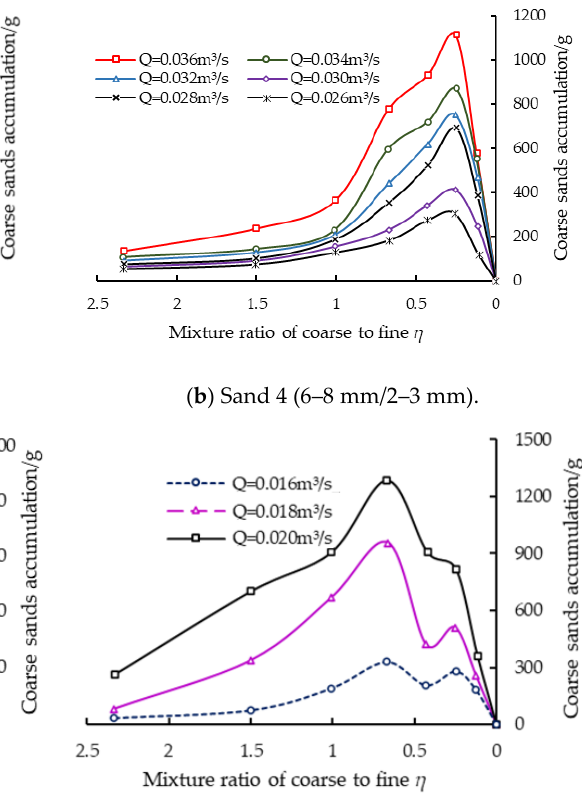
Figure 14. Relationships between the accumulation of the transported coarse sands and the mixture ratio η . The relationship curves show the experimental data under various flow conditions. However, they have similar trends as those in Figures 11–13. This indicates that the transport rate of the total bed load is closely associated with coarse sediment transport.